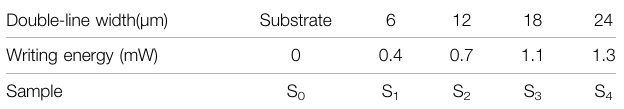
TABLE1 | The details of the samples.